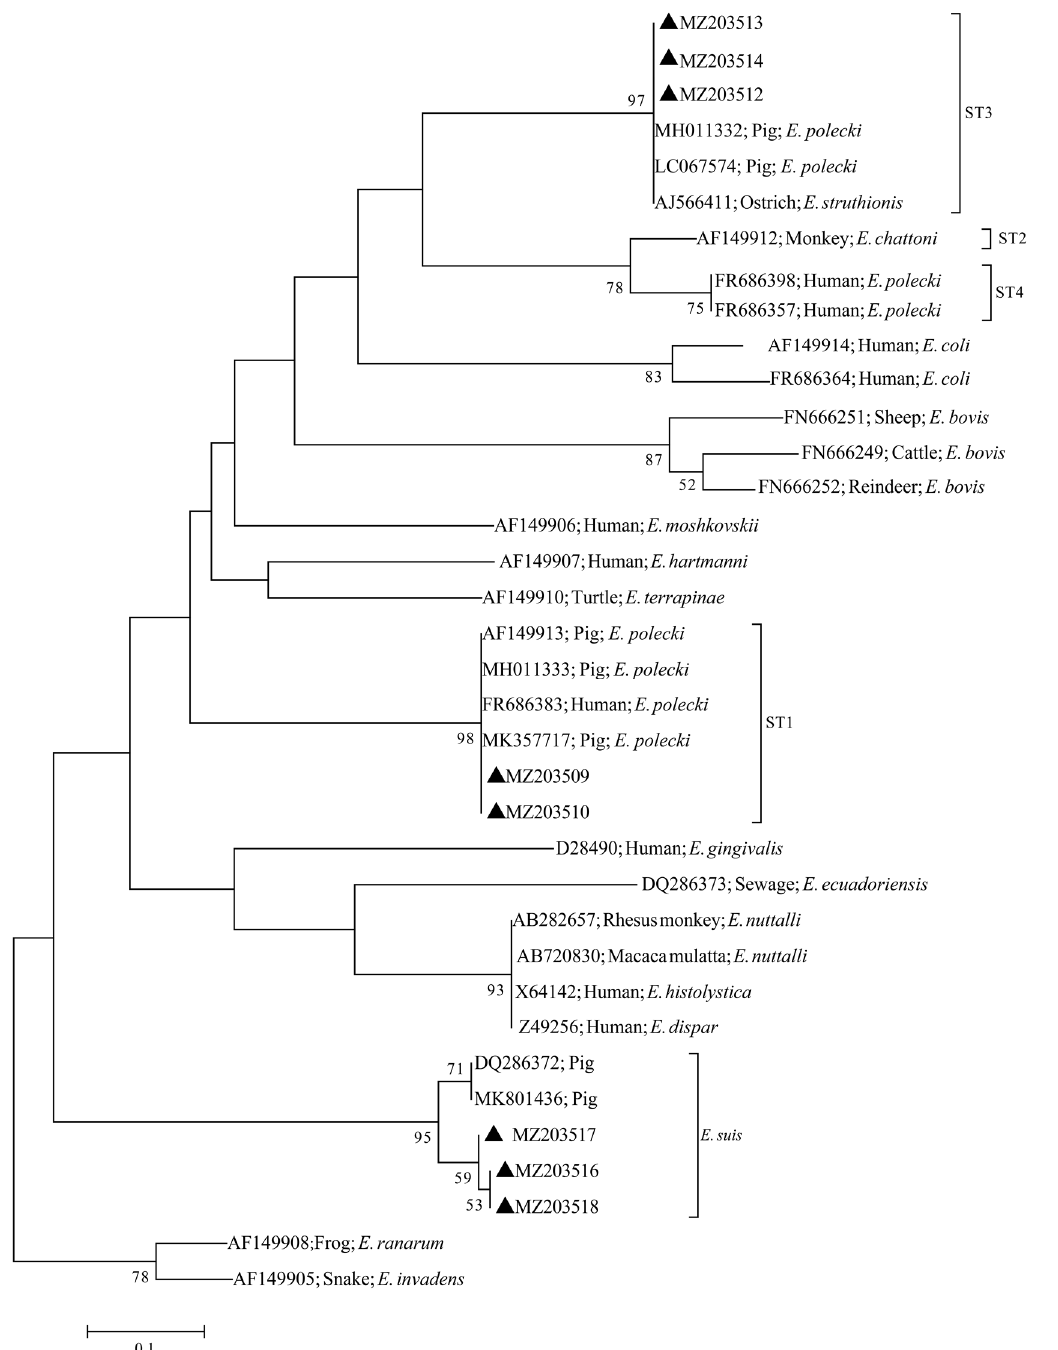
Figure 2. Phylogenetic analysis of Entamoeba spp. using maximum likelihood (ML) method based on the SSU rRNA gene. The numbers on the branches represent percent bootstrapping values from 1000 replicates, with values of more than 50% shown in the tree. Marked with solid black triangles are species/subtypes identified in this study.